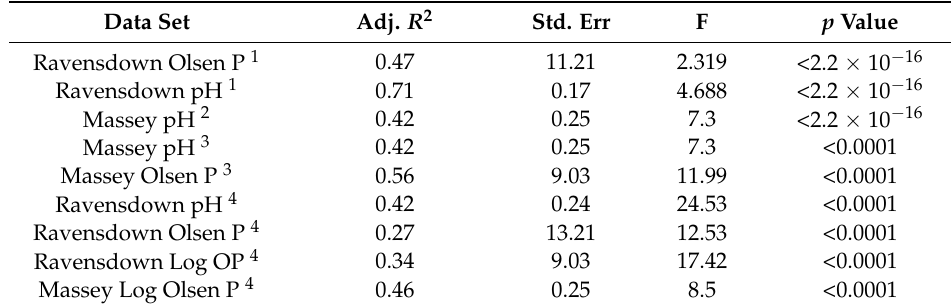
Table 2. Summary of regression analyses.